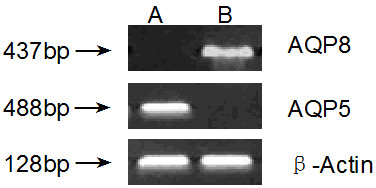
Representative PCR analysis to detect the expression of AQP5 and AQP8 in clinical colorectal samples. (A) Adjacent normal colon tissue. (B) Colorectal carcinoma tissue. AQP5 mRNA was not detected in adjacent normal colon tissue but was abundant in colorectal carcinoma tissue. By contrast, AQP8 mRNA was abundant in adjacent normal colon tissue but was not detected in colorectal carcinoma tissue. β-actin served as the internal control.